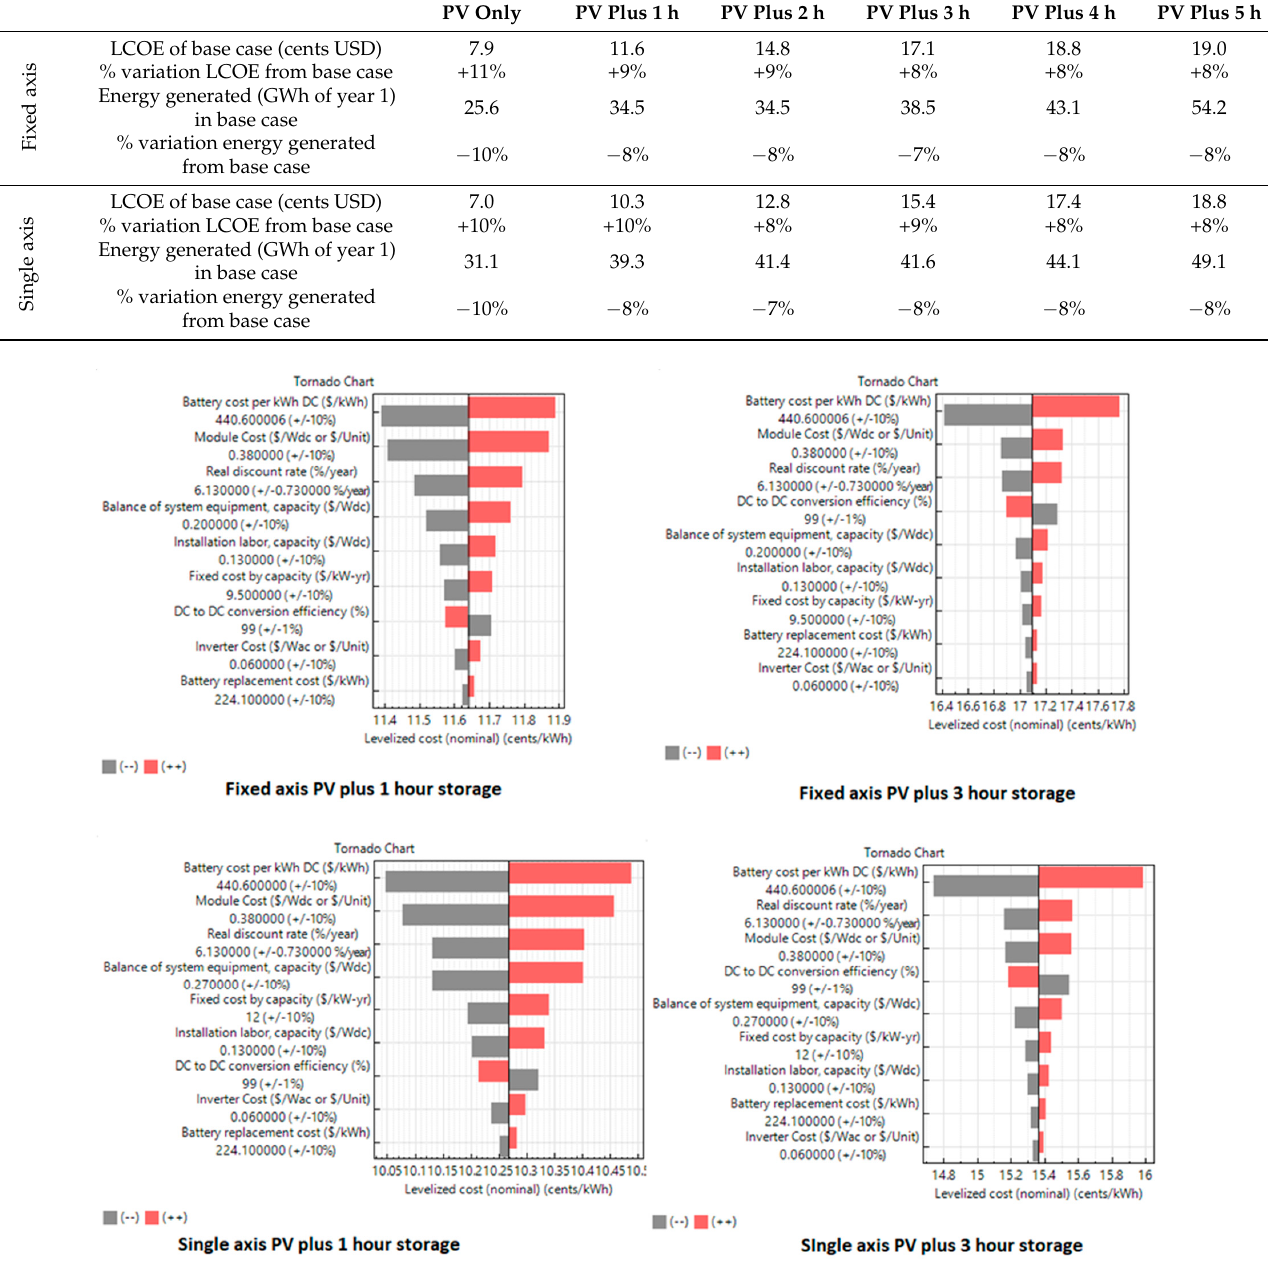
Figure 14. Sensitivity analyses results.